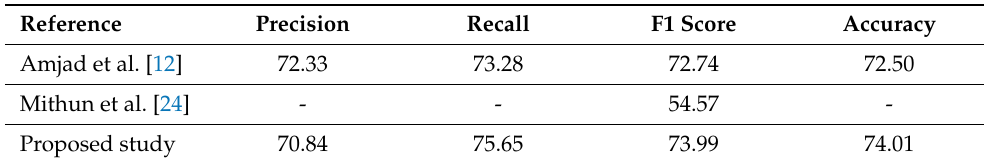
Table 14. Performance comparison with base